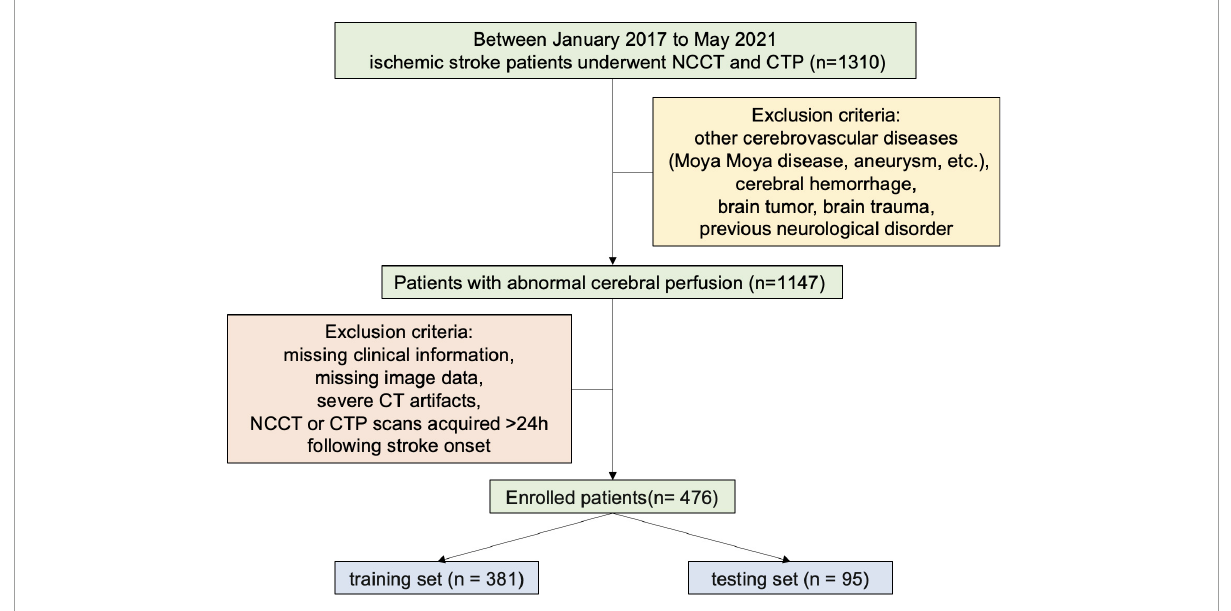
FIGURE1 Patient sample inclusion flowchart. NCCT, non-contrast CT; CTP, CT